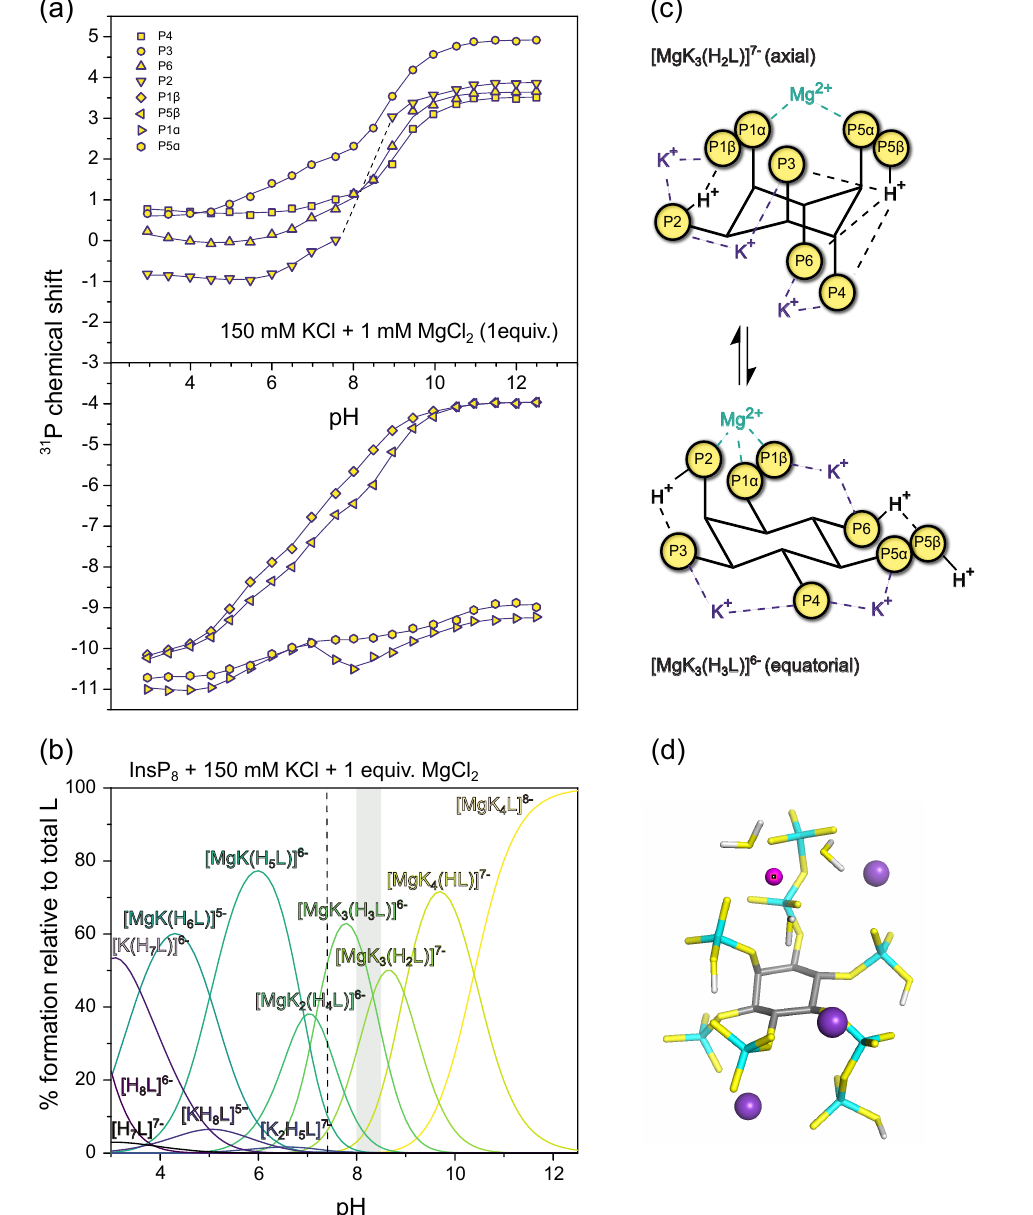
Figure 6. 31 P-NMR titrations of InsP 8 . ( a ) Chemical shift with 150 mM KCl and 1 mM MgCl 2 at 22 ◦ C, pH 3.0–12.5. Dots represent experimental chemical shift data, separated into monophosphate (position 2, 3, 4, 6) and pyrophosphate groups (position 1 and 5). Lines represent theoretical chemical shift values based on the protonation model and calculated protonation constants. ( b ) Abundance of different or K + -Mg 2+ -complexes (in the presence of 150 mM KCl) of InsP 8 (L) over the pH range. pH 7.4 is indicated by a dashed line. The grey area represents the pH-range with the biggest chemical shift changes in a. ( c ) Schematic view of the highest protonated axial and the lowest protonated equatorial complexes [MgK 3 (H 2 L)] 7 − and [MgK 3 (H 3 L)] 6 − ( d ) DFT optimized structure of the most abundant complex at pH 7.4, [MgK 3 (H 3 L)] 6 −